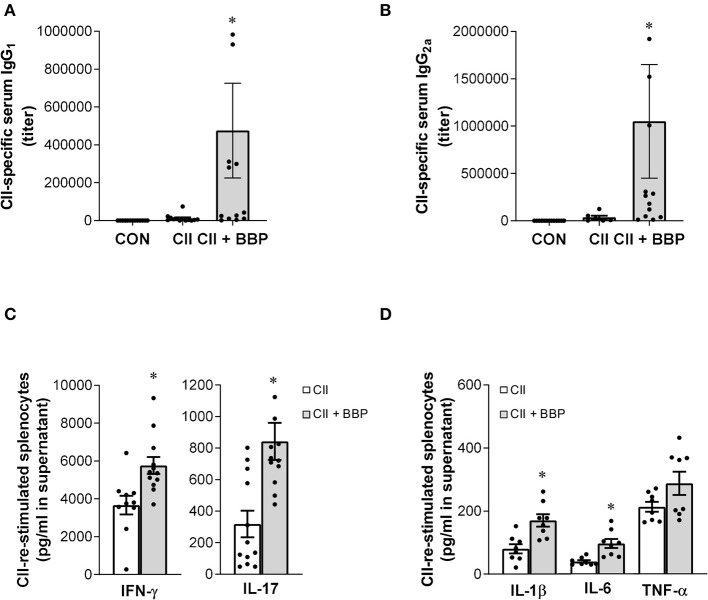
Perinatal exposure to BBP increases IgG antibody level, induces IFN-γ and IL-17 production and the release of pro-inflammatory cytokines in collagen-treated offspring. Effect of an exposure of CII-immunized DBA/1 mice to BBP on IgG1
(A) and IgG2a antibody levels (B), and on IFN-γ and IL-17 production (C) and the release of IL-1β, IL-6, and TNF-α in CII-re-stimulated splenocytes (D). Data are expressed as mean ± SEM, n ≥ 13 (A,B) and n ≥ 8 (C,D) animals per group; *P < 0.5, unpaired t-test.